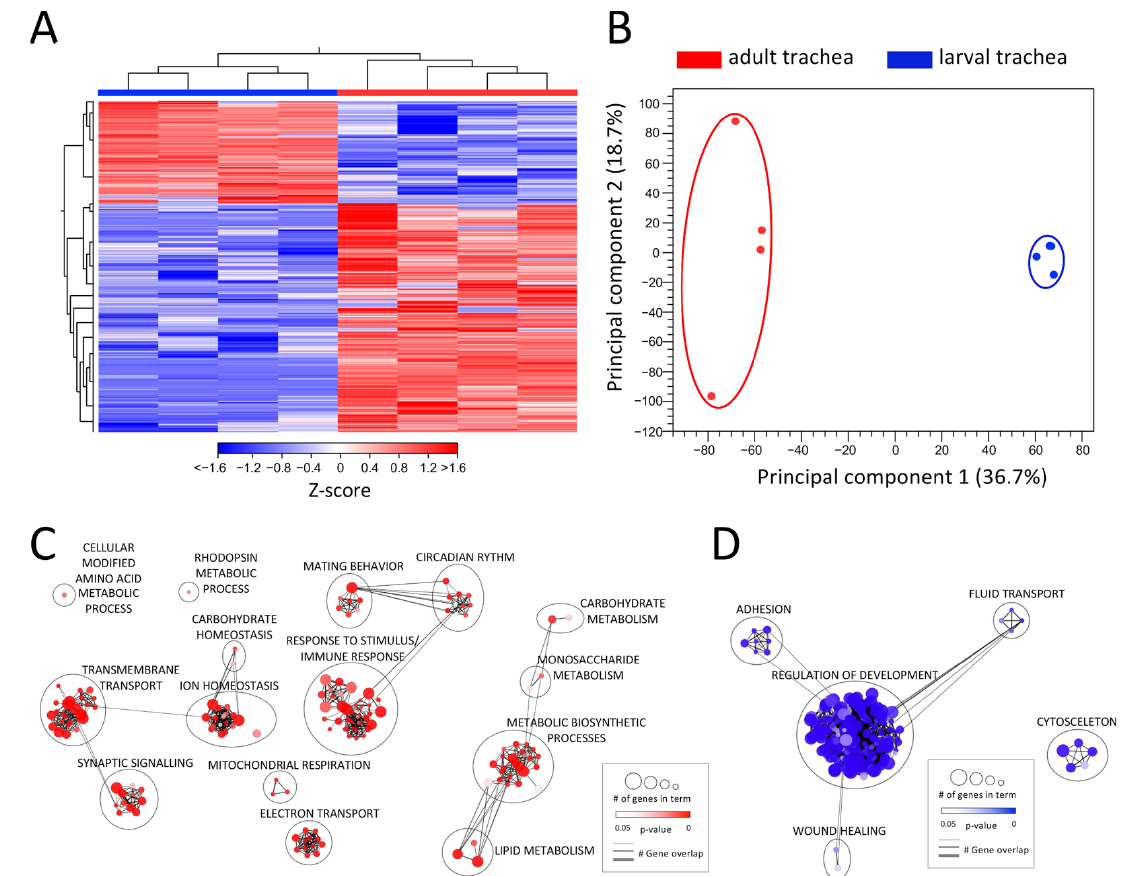
Figure 2. Comparing the transcriptomic signatures of adult and larval trachea. ( A ) Heatmap of all DEGs between adult tracheal (red) and larval trachea (blue). ( B ) PCA of all replicates from adult trachea and larval trachea. Circles were added manually. ( C , D ) GO analysis with the upregulated ( C ) and downregulated ( D ) DEGs with a cutoff value of FDR < 0.05. Node size represents the number of associated genes in the GO term. The node color represents the p -value. Edge appearance represents the number of shared genes between the GO terms.